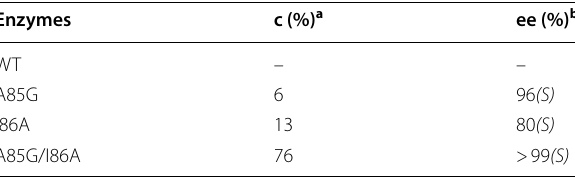
Table 1 Results of site-directed mutagenesis of A85 and I86